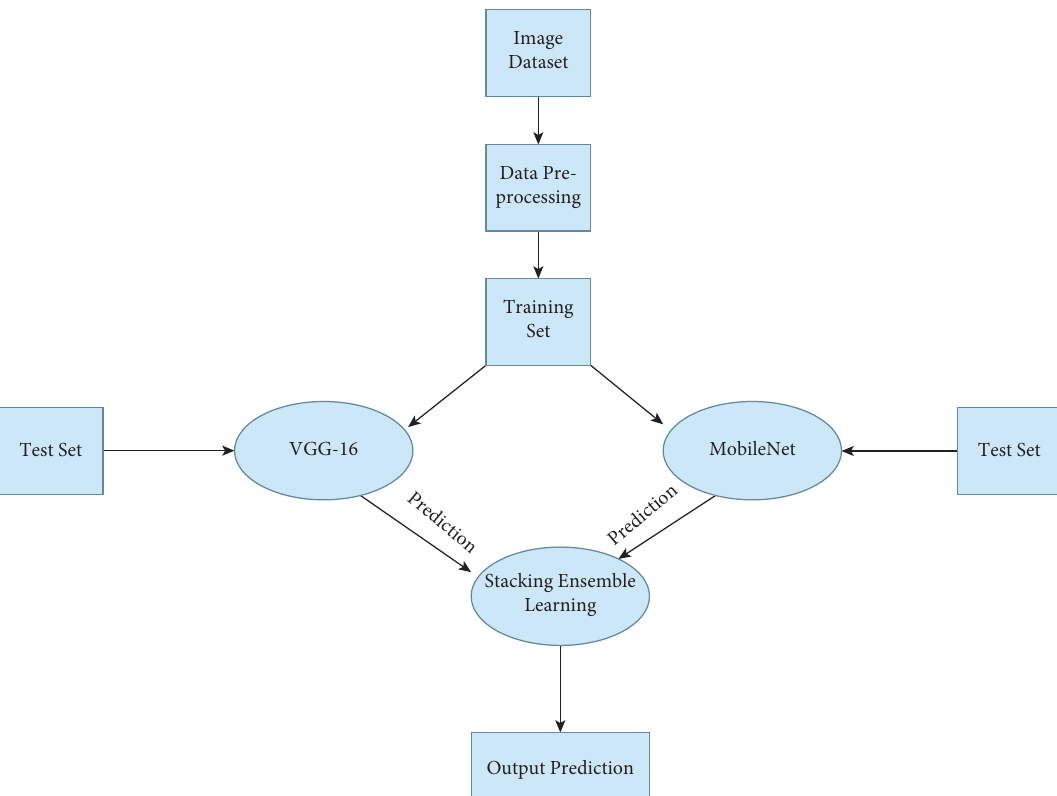
Figure 6: Proposed hybrid technique’s work